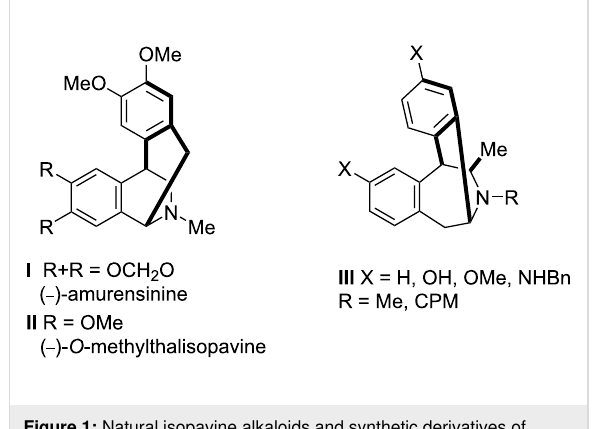
Figure 1: Natural isopavine alkaloids and synthetic derivatives of isopavine. rearrangement of dihydromethanodibenzoazocines. Dihy- dromethanodibenzoazocines are example of strained, methy- lene-bridged tetrahydroisoquinolines (Figure 2) that have at- tracted much interest of scientists not only due to their resem- blance to isopavines and thus their medicinal significance in the central nervous system but also as a building blocks for the syn- thesis of alkaloids [10,11].